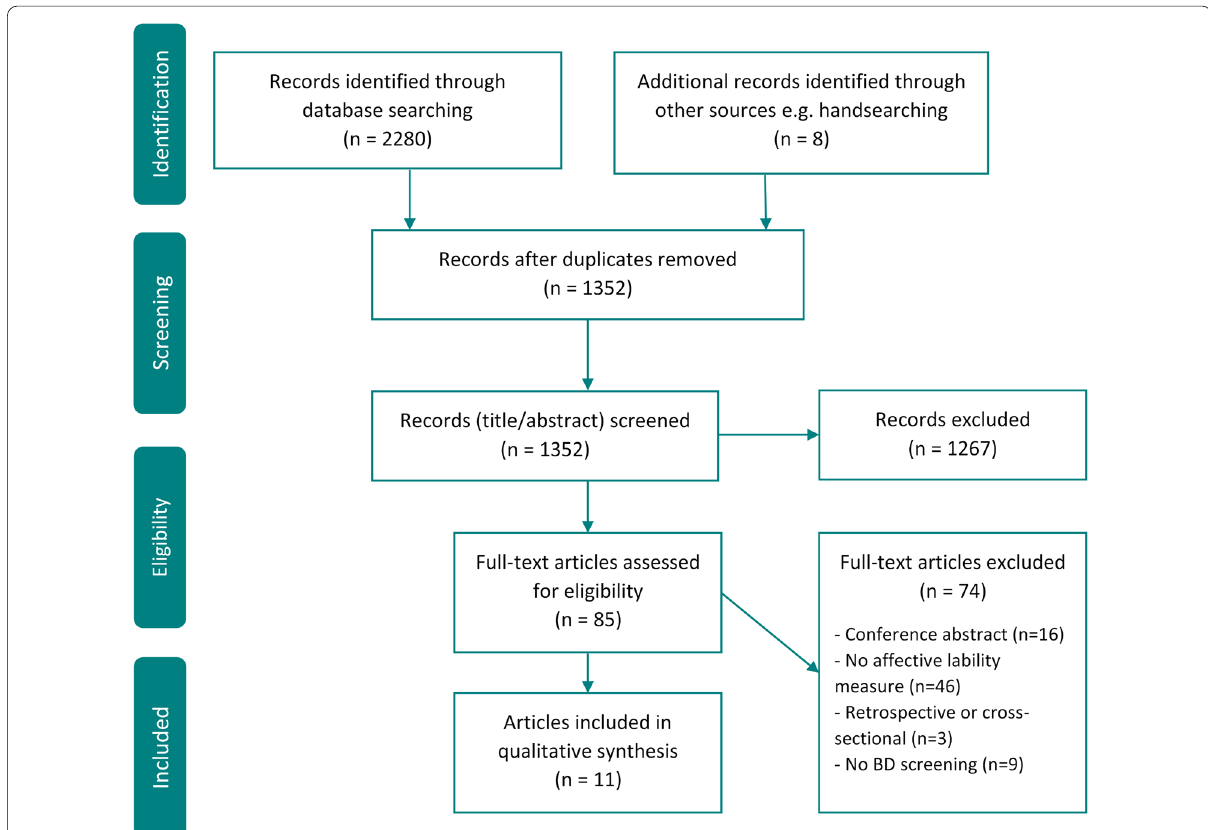
Fig. 1 PRISMA flow diagram of the study selection process. Study flow diagram showing the Preferred Reporting Items for Systematic Reviews